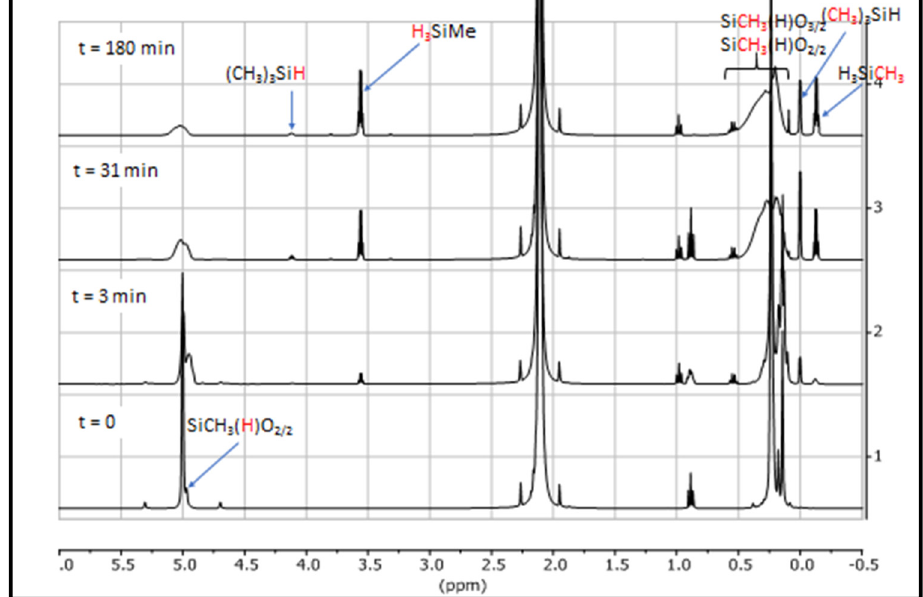
Figure 2. The 1 H NMR spectra acquired during reaction of 20 wt% PHMS solution in toluene in the presence of 1 × 10 − 2 mol/L of B(C 6 F 5 ) 3 at 30 °C.